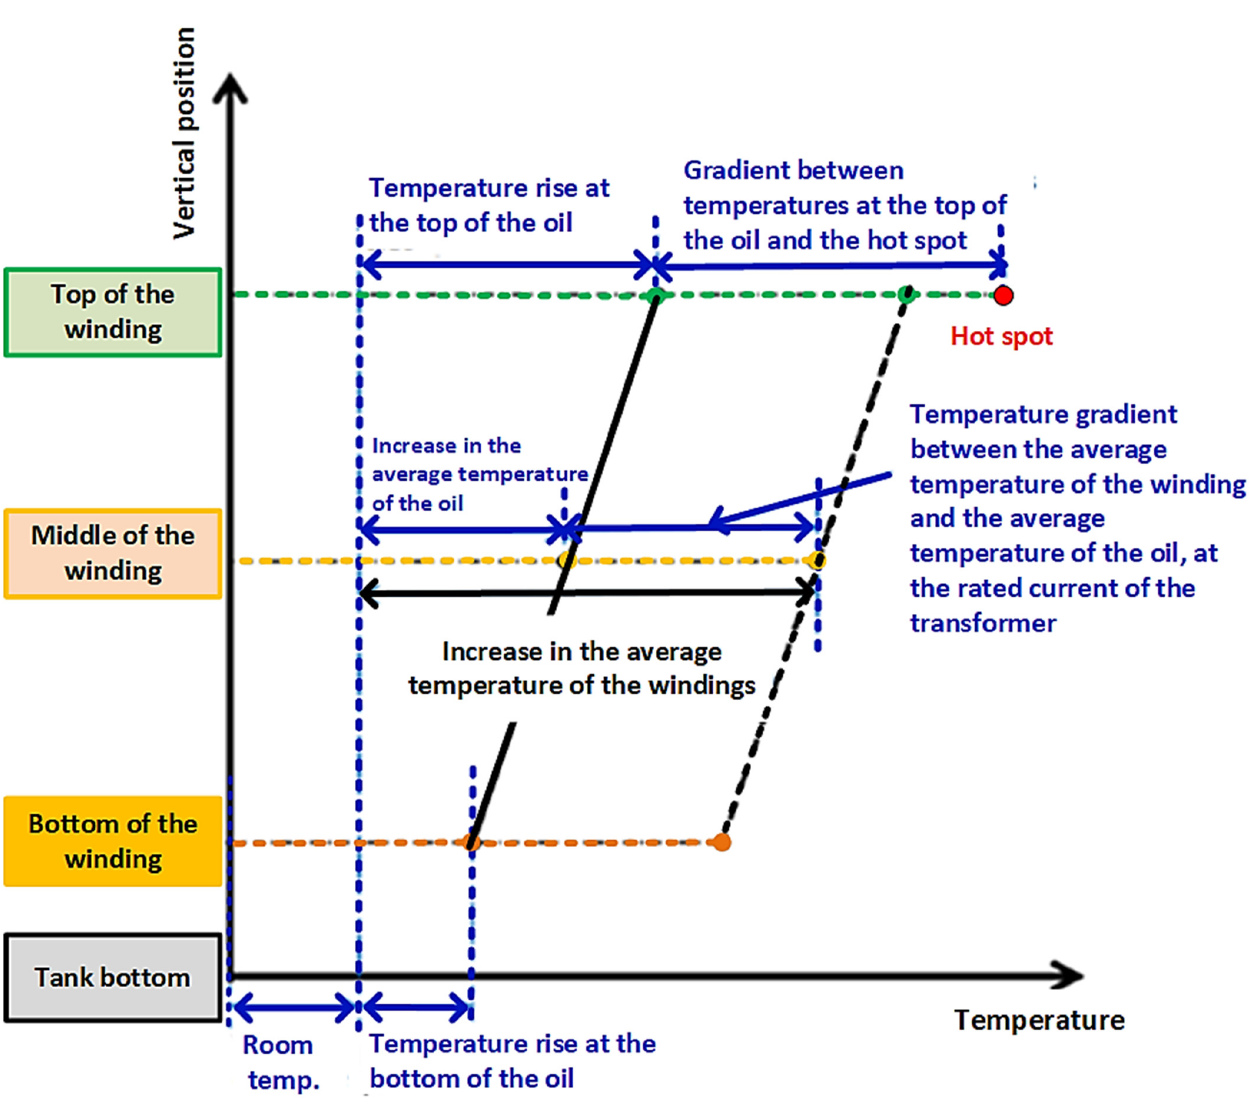
Figure 15. Diagram for the thermal model of the power transformer. Adapted from [63], licensed under CC BY 4.0.